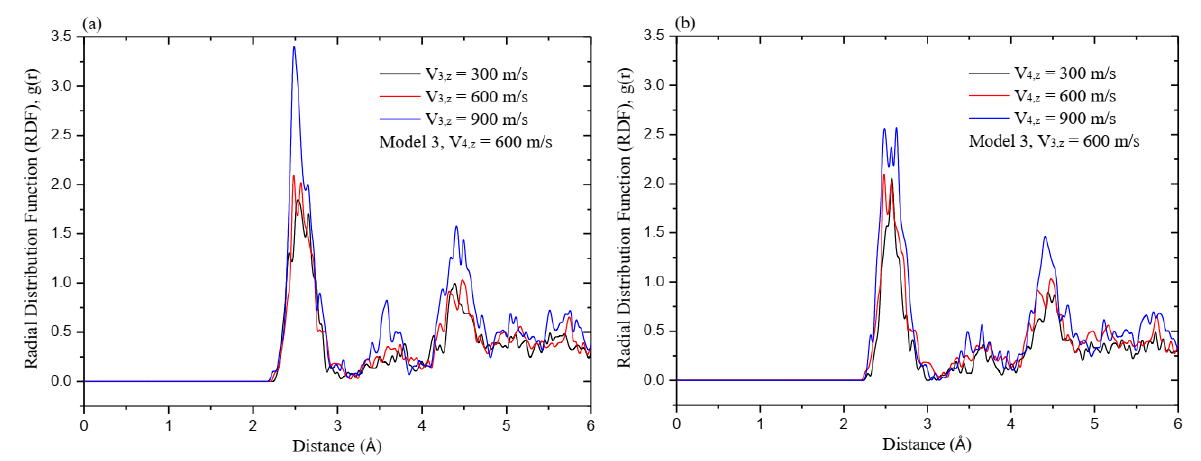
Figure 16. RDFs in Model 3: ( a ) V z ,4 = 600 m/s and various V z ,3 and ( b ) V z ,3 = 600 m/s and various V z ,4